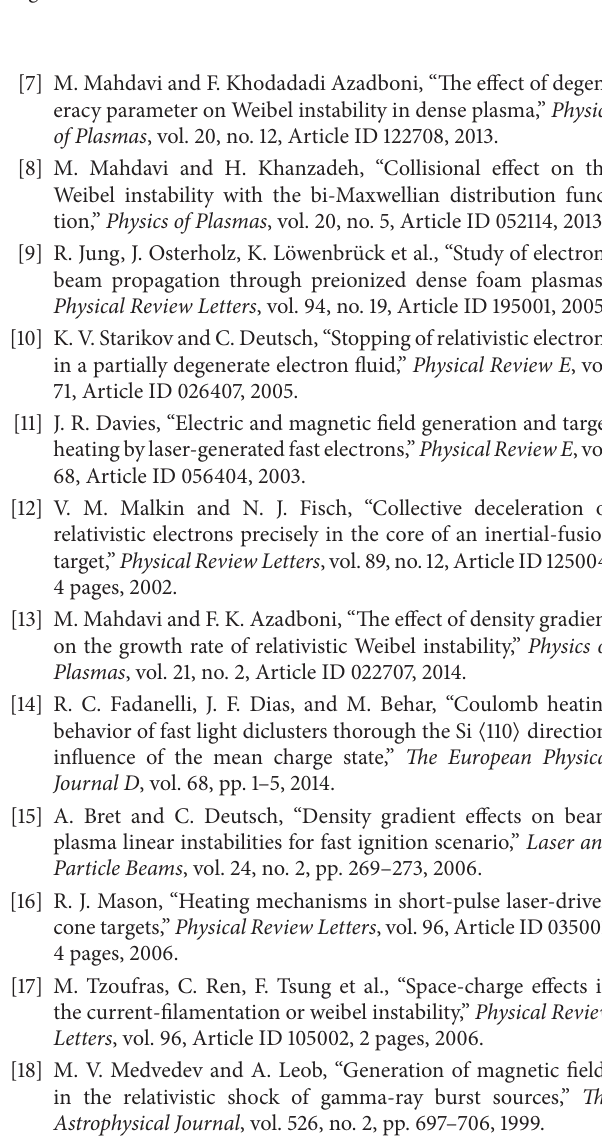
gradient in large wavelength will decrease the